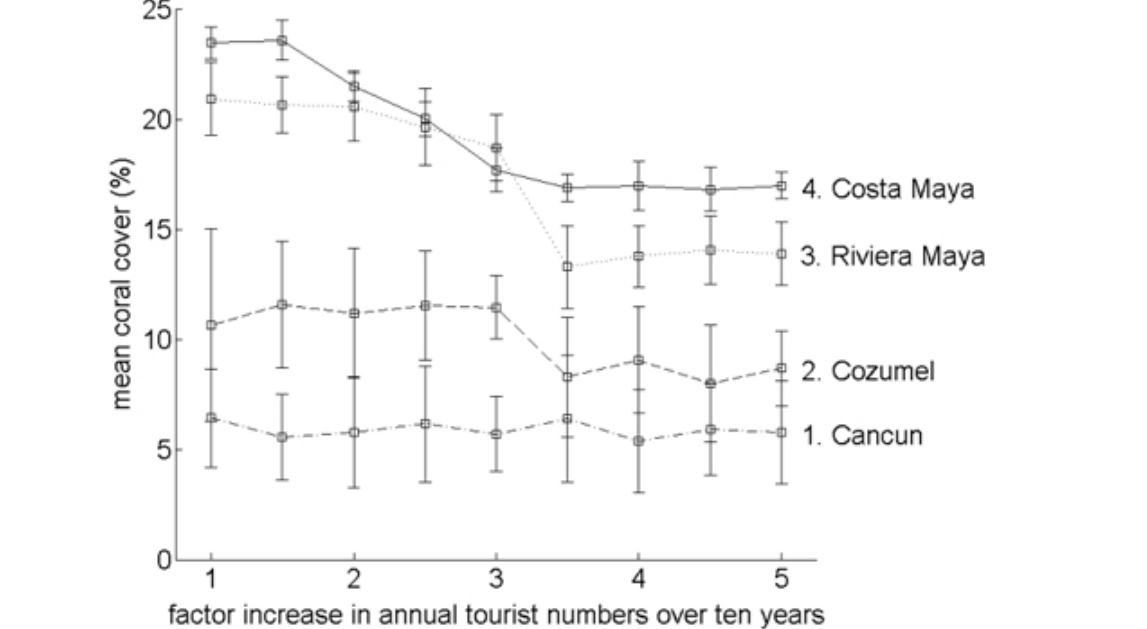
Fig. 4. Average modeled coral cover in each of the four Quintana Roo municipalities under hypothetical scenarios for increasing tourist visits. These scenarios assume increases in annual tourist visits for the region by a factor of between one (i.e., no increase beyond the number of visits in 2005) and five (i.e., five times 2005 visits) over a 10-year period. Mean coral cover refers to the average cover for each municipality after 10 years. Error bars represent 95% confidence intervals from the 10 runs of the Monte Carlo